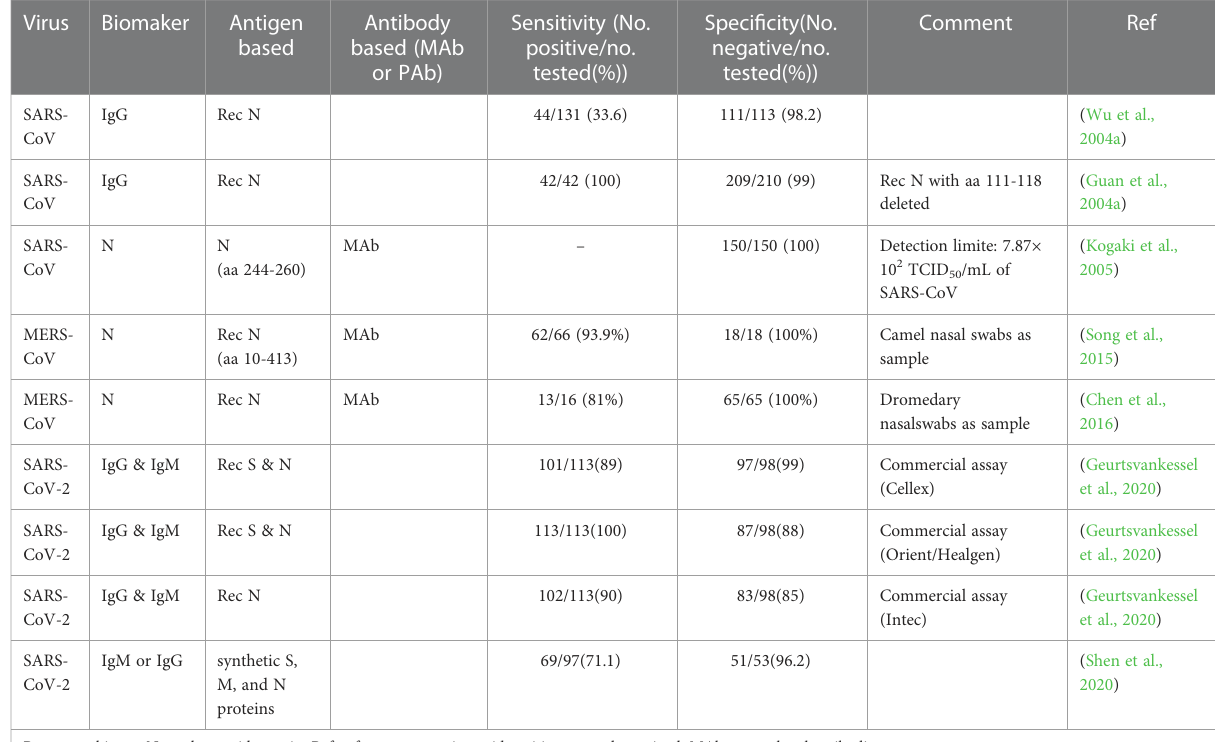
TABLE 6 ICT for antibody detection validated by clinical